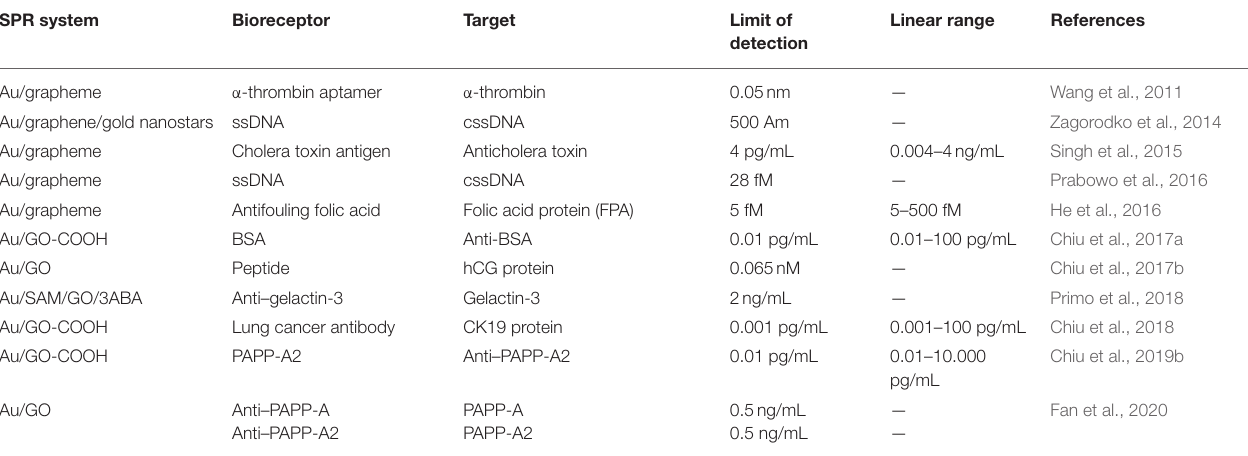
TABLE 1 | Graphene-based SPR biosensor design, detection limits, and the resulting linear range.